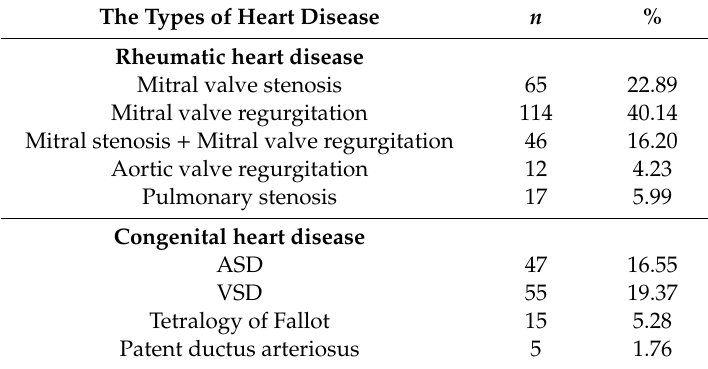
Table 2. Types of cardiac disease among study patients ( n = 284).